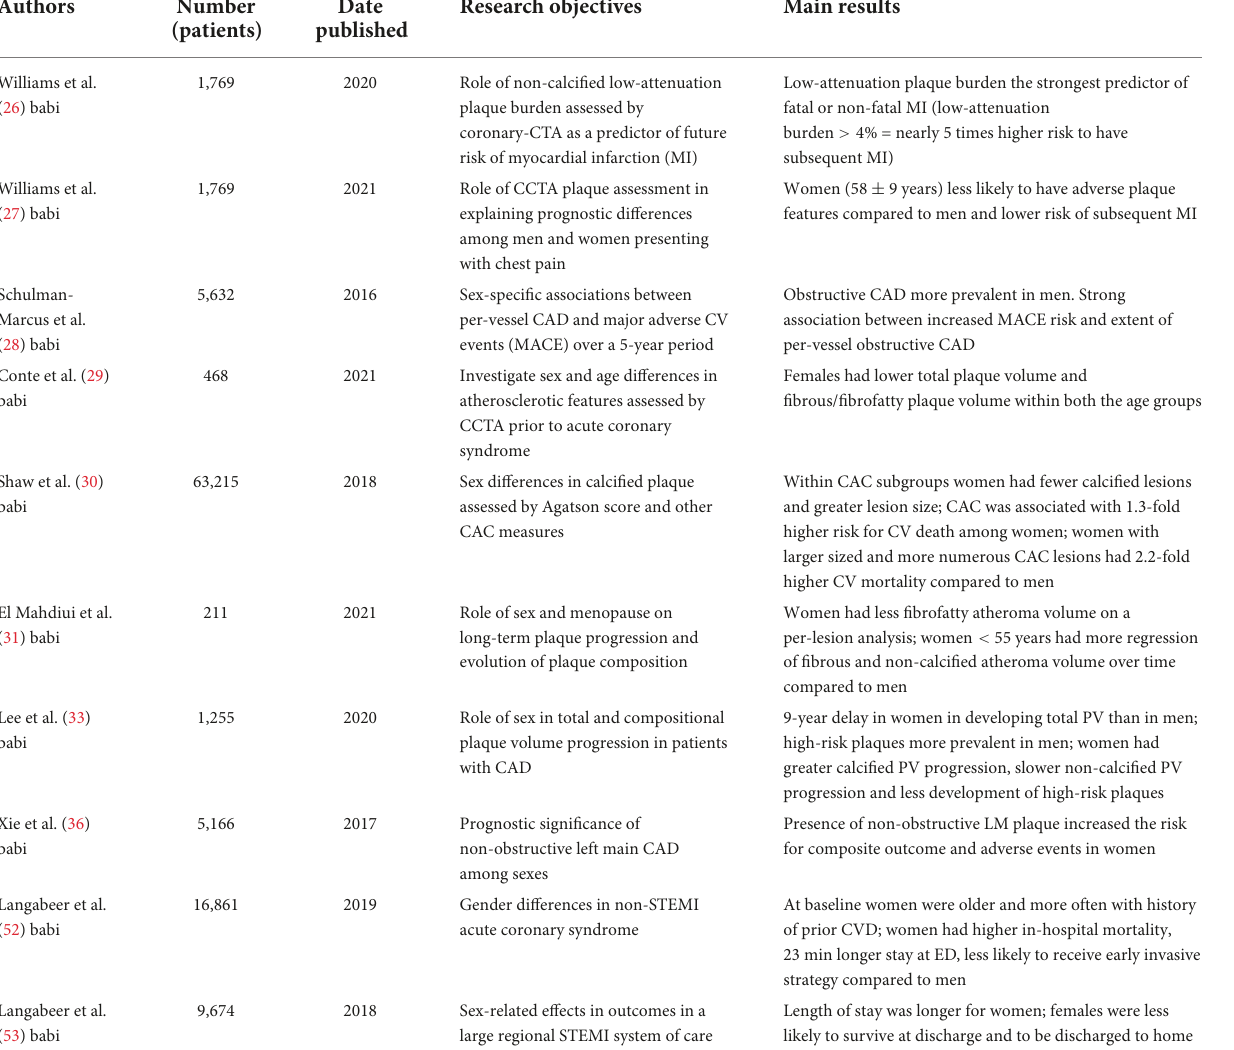
TABLE 1 Studies regarding coronary